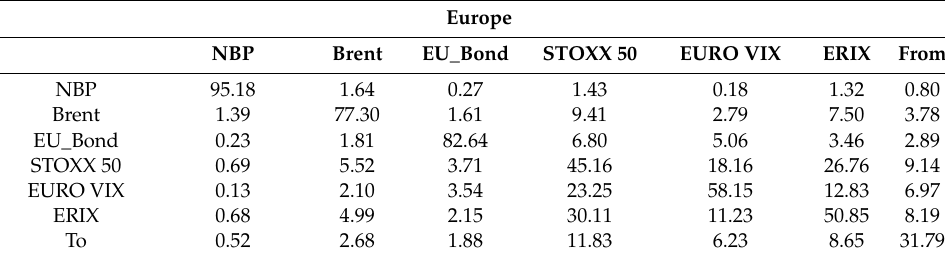
Table A4. Return spillover results (Europe).